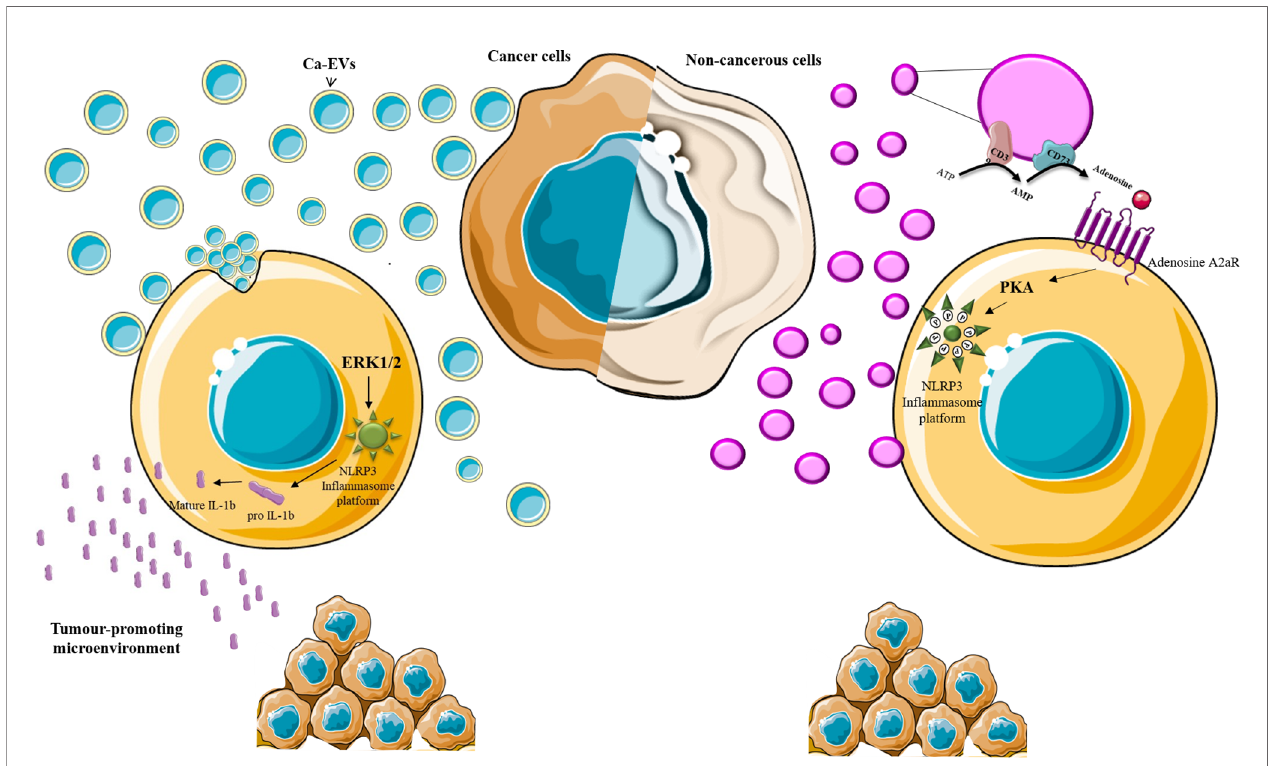
FIGURE 1 | EVs and in fl ammasome. Schematic representation of EVs-induced effect on in fl ammasome activation. Ca-EVs (light blue) are up-taken by non- cancerous cells and, via the induction of intracellular signaling pathways, including ERK1/2 MAPK, induce in fl ammasome platform assembly and the maturation of IL-1 b which release affects the microenvironment in a tumor-promoting fashion. EVs released by non-cancerous cells violet may produce soluble factor (Adenosine) that, via receptor (adenosine A2a receptor) engagement on the target cell, activates protein kinases (PKA) which impedes in fl ammasome platform assembly through NLRP3 phosphorylation